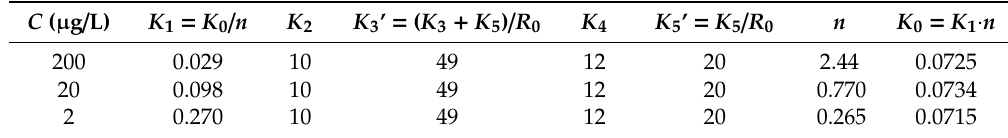
Table 2. Calculated constants for three tested EE2 concentrations, where C is the tested concentration, n is the molar ratio, K 1 – K 5 are the overall rate constants, K 0 is the basic rate constant of the first step in the formation of the adduct, and R 0 is the number of total receptors.